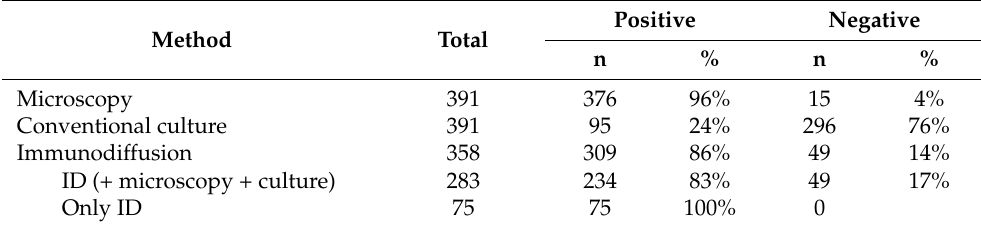
Table 6. Applied methods for the diagnosis of